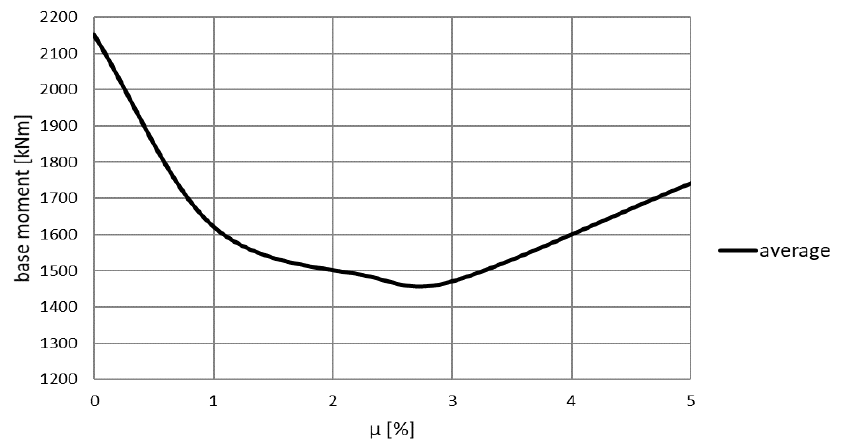
Figure 12. Base moment against the mass ratio, μ considering the TMD positioned at 40.00 m.